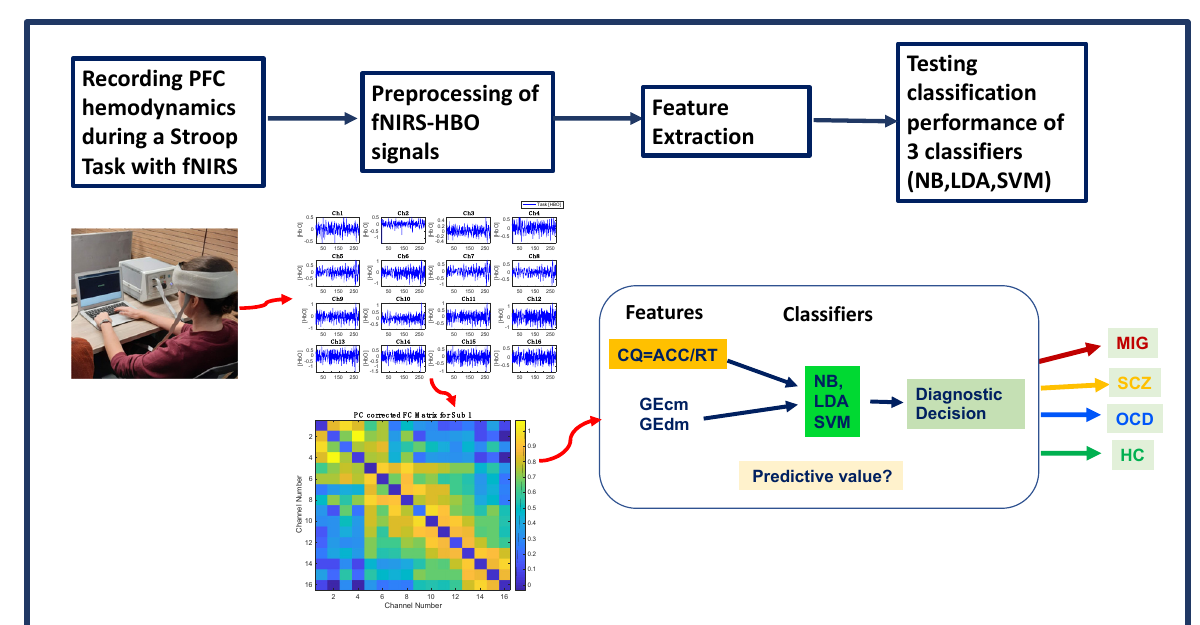
Figure 5. Flowchart of the system design.